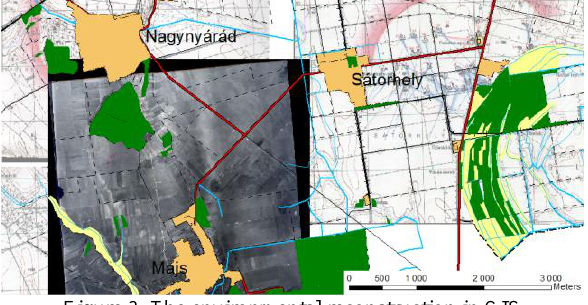
Figure 3. The environmental reconstruction in